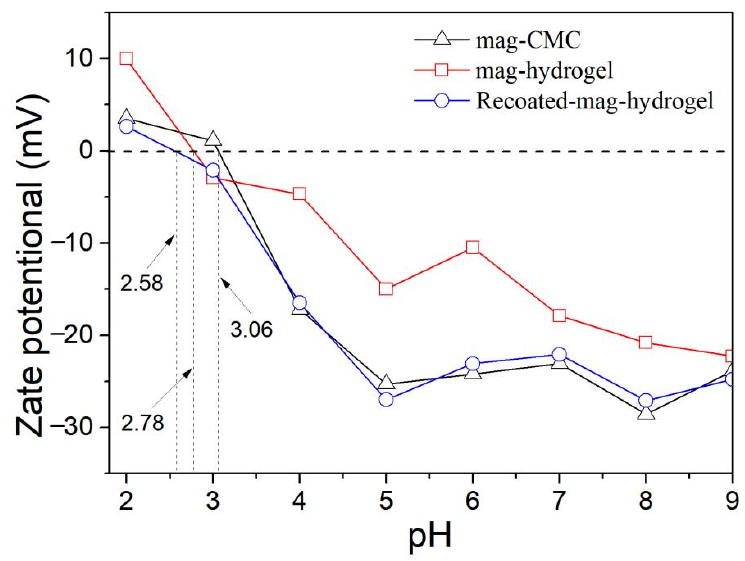
Figure 7. Zeta potentials of magnetic nanocomposites at various solution pH values.